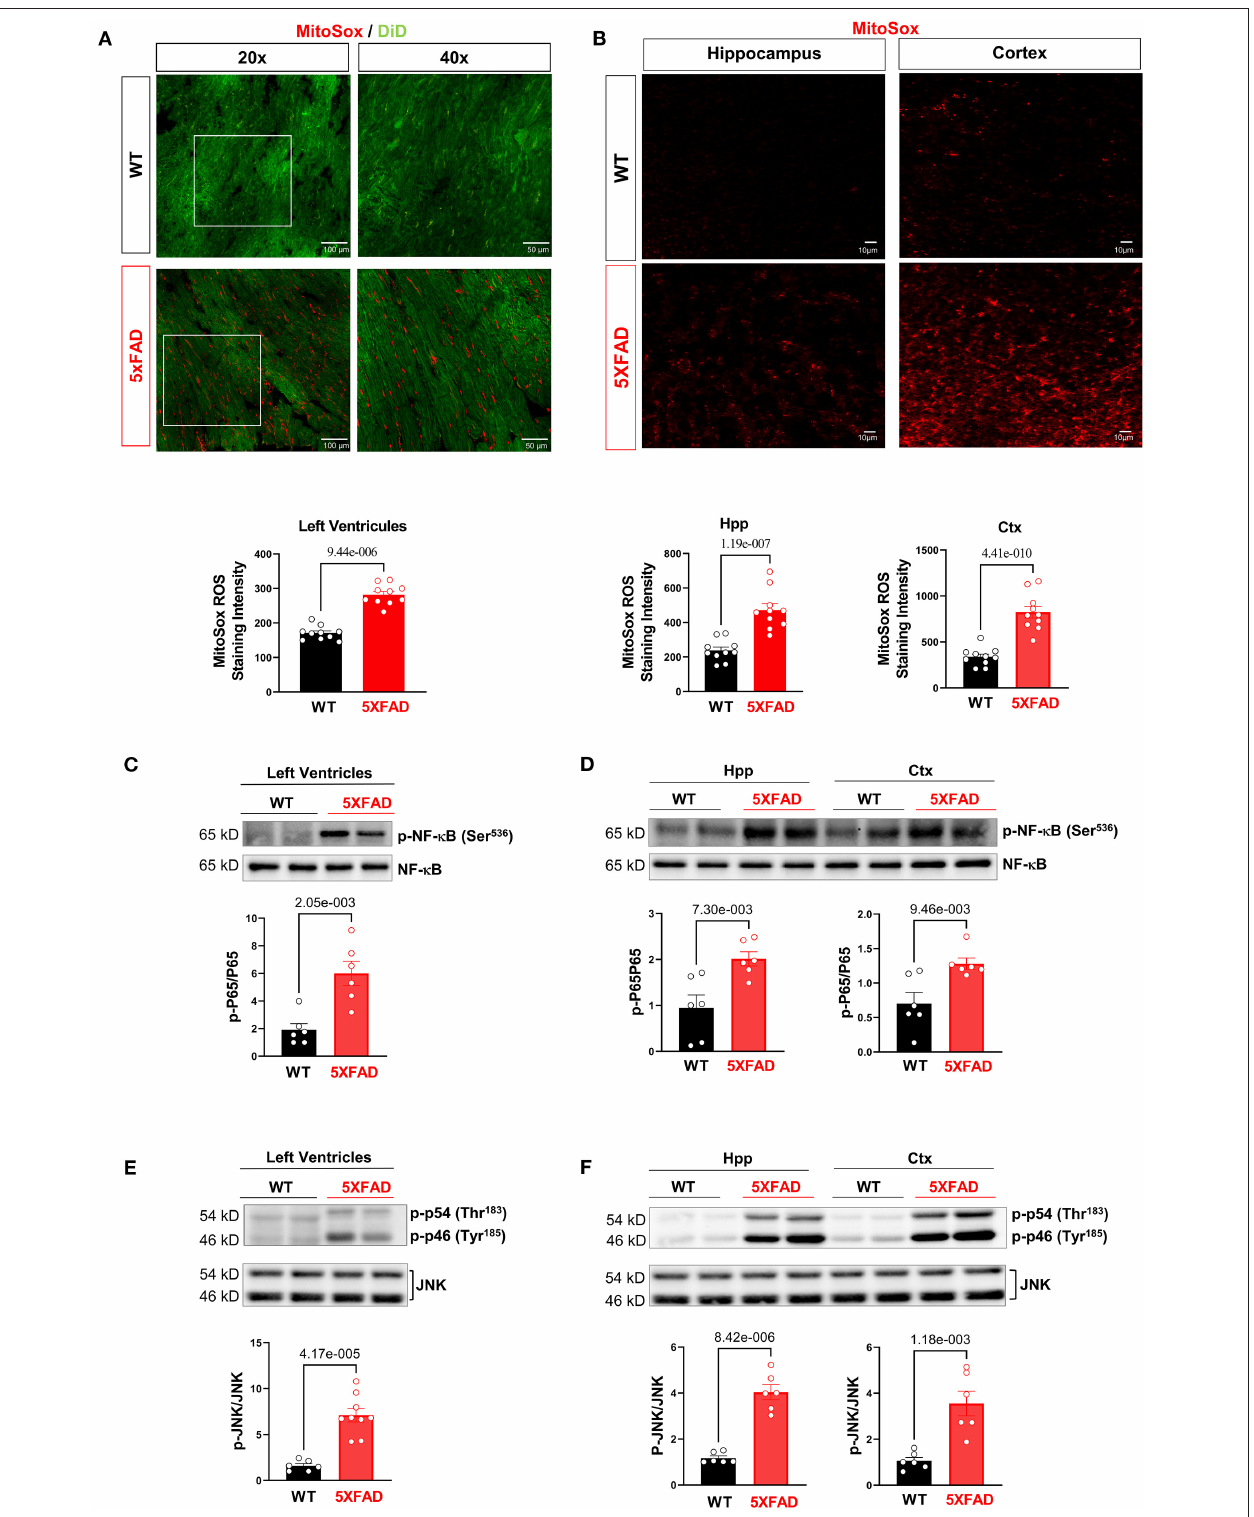
FIGURE 4 | Excessive oxidative stress and provoked cellular proinflammatory signaling in 5XFAD heart and brain. (A) MitoSox staining showed increased superoxide accumulation in the heart of 5XFAD (6 months) mice vs. WT (6 months) mice. Biological replicates N = 3 for each group. P -value determined by two-tailed students t -test. (B) MitoSox staining showed increased superoxide accumulation in the hippocampus and cortex of 5XFAD (6 months) mice vs. WT (6 months) mice. Biological